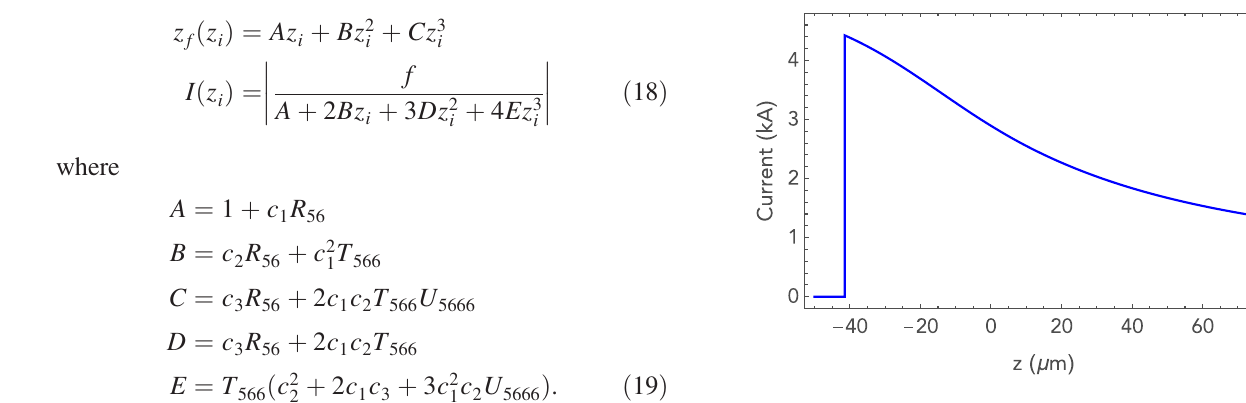
FIG. 13. Linearly ramped current profile calculated from Eq. (17) and obtained through optimizing R 56 , T 566 , and U 5666 . Note the head of the bunch is on the left-hand side, at negative values of z .